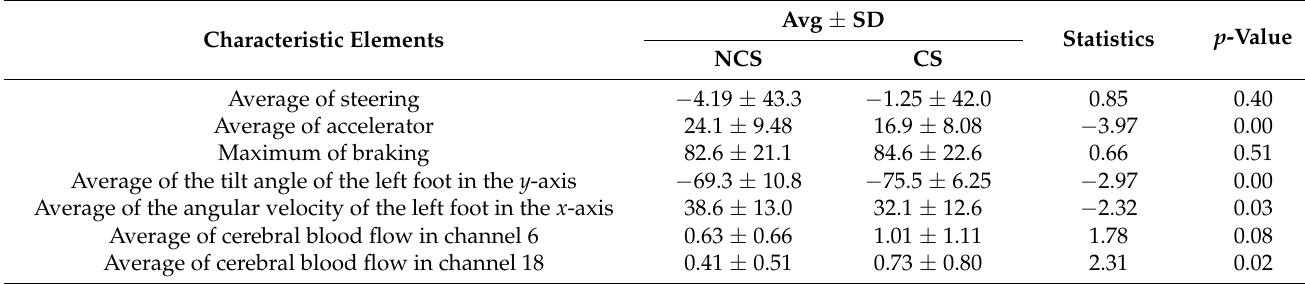
Table 9. Characteristics of behavior and cognition of young drivers when they feel impatient.